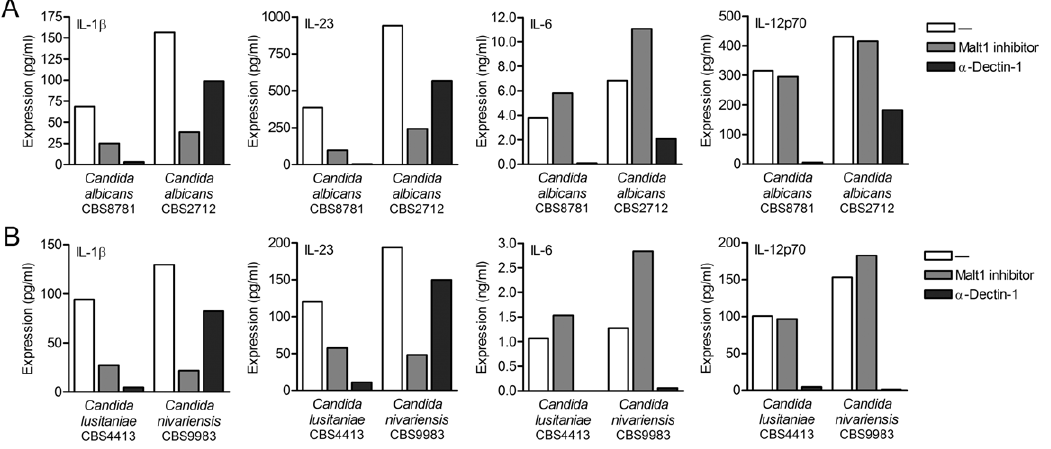
Figure 4. Malt activation controls IL-1 b and IL-23 production in response to Candida spp. (A and B) Cytokine production was determined by ELISA in supernatants of DCs stimulated with Candida albicans spp. (A), C. nivariensis or C. lusitaniae (B) in the absence or presence of Malt1 paracaspase inhibitor z-VRPR-FMK or blocking dectin-1 antibodies. Data are representative of three independent experiments.